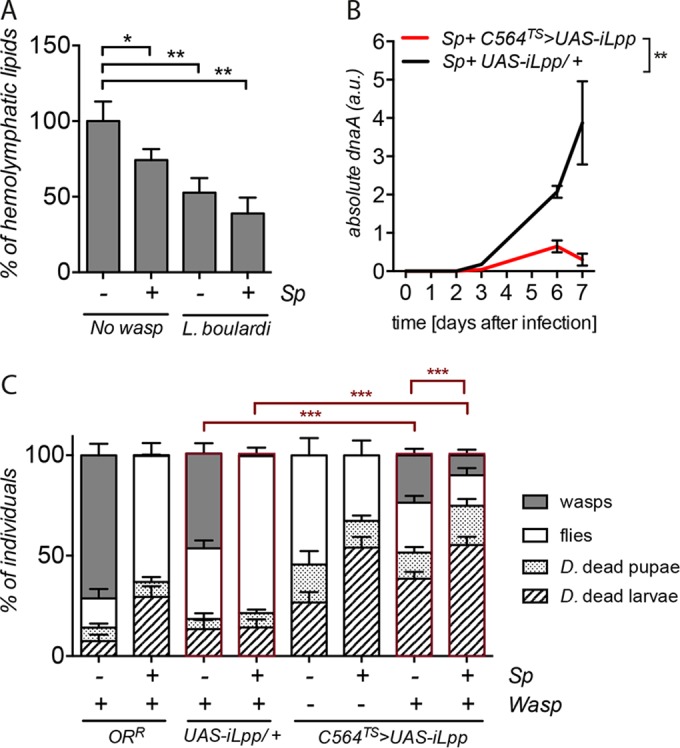
S. poulsonii and wasps compete for hemolymph lipids. (A) Quantification of hemolymphatic DAGs in D. melanogaster flies with or without wasp infestation and harboring (+) or not harboring (−) S. poulsonii (Sp). *, P = 0.0041; t = 3.268; df = 19; **, P = 0.0450; t = 2; df = 18; **, P = 0.0020; t = 3.612; df = 18; using unpaired Student’s t test. (B) Absolute quantification of S. poulsonii titers by qPCR. **, P = 0.00286; two-way ANOVA; see Table S1 in the supplemental material for details. (C) Fly survival after Lpp knockdown mediated by the activation of UAS-iLpp in the fat body using a specific thermosensitive driver (C564-Gal4TS, C564TS>). UAS-iLpp in the absence of driver (UAS-iLpp/+) and Oregon-R (ORR) flies were used as negative controls. (C) D. melanogaster (D.) dead larvae and pupae, emerging fly adults, and wasp adults. Results are percentages of a minimum of 270 D. melanogaster larvae. ***, from left to right, respectively: P < 2.2 × 10−16; chi-square = 153.96; df = 3; P < 2.2 × 10−16; chi-square = 620.75; df = 3; P < 2.2 × 10−16; chi-square = 84.458; df = 3; using Pearson’s chi-square test. (A to C) Results are means ± SEM from at least three independent experiments.